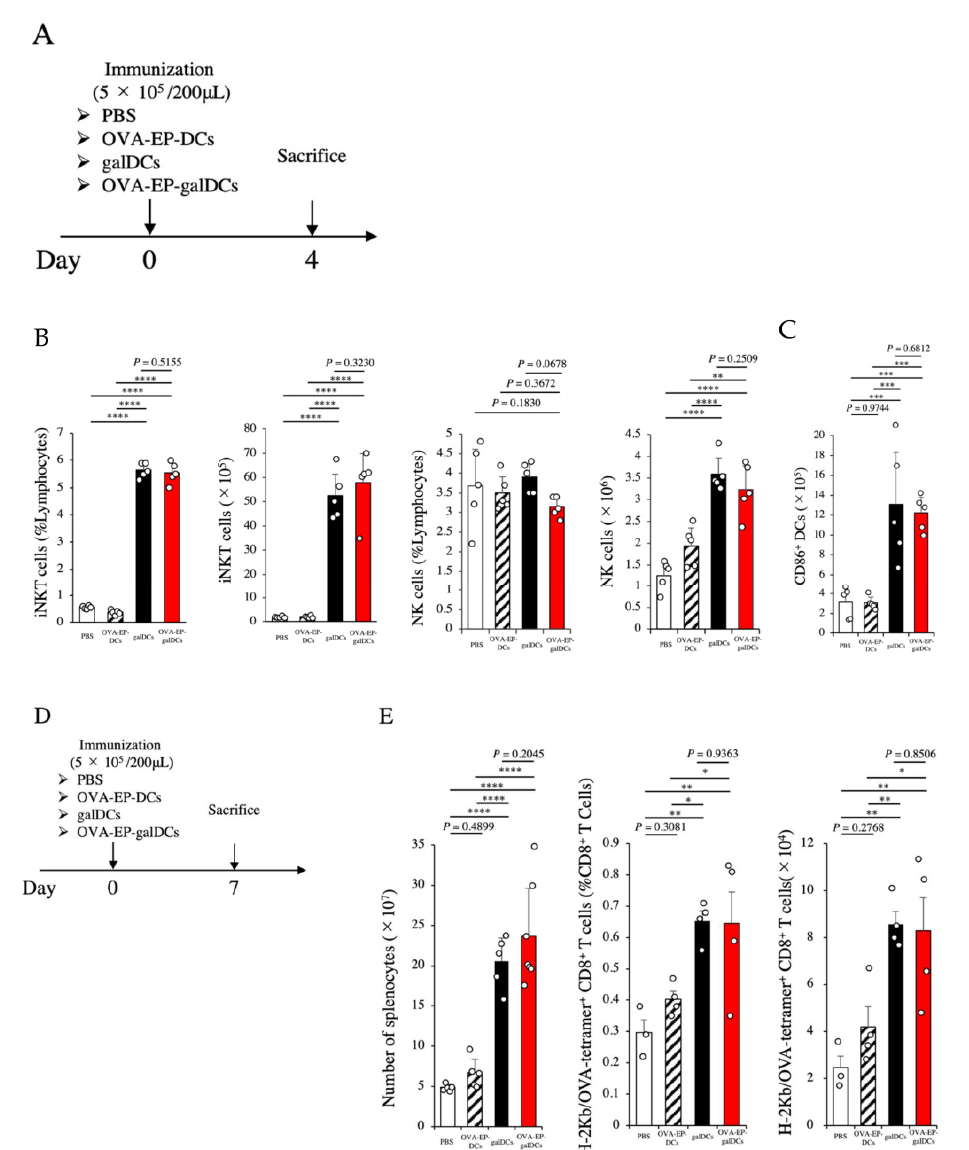
Figure 3. OVA-EP-galDCs induced iNKT cells, NK cells, and DCs in the spleen. ( A ) Experimental schema is shown. C57BL/6 mice were immunized with PBS, OVA-EP-DCs, galDCs, or OVA-EP-galDCs (5 × 10 5 cells/mouse). OVA-EP-DCs mean OVA-electroporated DCs stimulated with LPS but not pulsed with α -GalCer. On day 4 after the immunization, the frequency and number of iNKT cells and NK cells, and the maturation of the DCs in the spleen were assessed by flow cytometry. ( B ) The frequency and the number of iNKT cells and NK cells in the spleen ( n = 5). The iNKT cells were defined as CD4 + CD1d tetramer + cells and NK cells were defined as CD3 − NK1.1 + cells. ( C ) The expression of CD86, which is the DC activation marker on splenic DCs, was assessed by flow cytometry. The DCs were defined as CD11c + cells. The number of CD86 + DCs is shown in each group ( n = 5). ( D ) Experimental schema is shown. C57BL/6 mice were immunized with PBS, OVA-EP-DCs, galDCs, or OVA-EP-galDCs (5 × 10 5 cells/mouse). On day 7 after the immunization, the number of splenocytes was counted. ( E ) The number of total splenocytes and the frequency and the number of OVA-specific CD8 + T cells in the spleen were assessed by flow cytometry ( n = 5). OVA-specific CD8 + T cells are defined as H-2Kb/OVA-tetramer + CD8 + cells in this figure. To analyze statistical differences among multiple groups, ANOVA with Holm’s post hoc test was performed. * p < 0.05, ** p < 0.01, *** p < 0.001, and **** p <